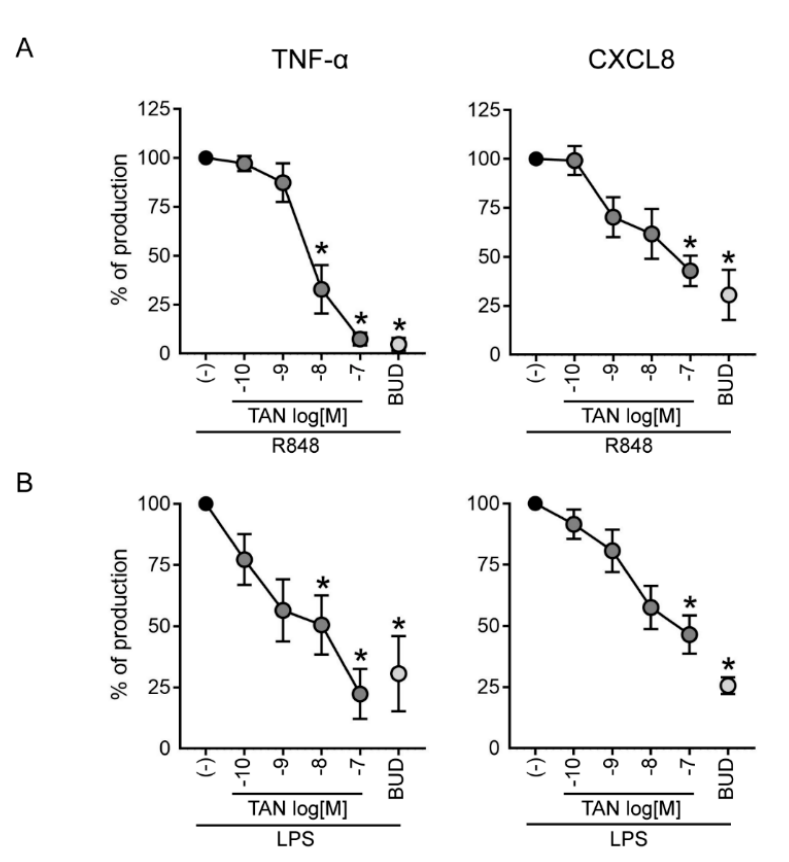
Figure 5. Regulation of pro-inflammatory cytokine secretion by tanimilast. Purified neutrophils were incubated with the indicated concentrations of tanimilast (TAN), budesonide at 10 − 7 M (BUD), and stimulated for 20 h with R848 (5 μ M) ( A ) or LPS (100 ng/mL) ( B ). Graphs depict the calculated inhibition of the secretion of TNF- α (left panels) and of CXCL8 (right panels). The concentrations of secreted TNF- α were 73.7 ± 13.26 pg/mL after R484, and 24.6 ± 7.8 pg/mL after LPS; the concentrations of secreted CXCL8 were 3739 ± 702 pg/mL after R848, and 3186 ± 468 pg/mL after LPS. Results are expressed as the mean ± SEM from four independent donors. * p < 0.05 One Sample t